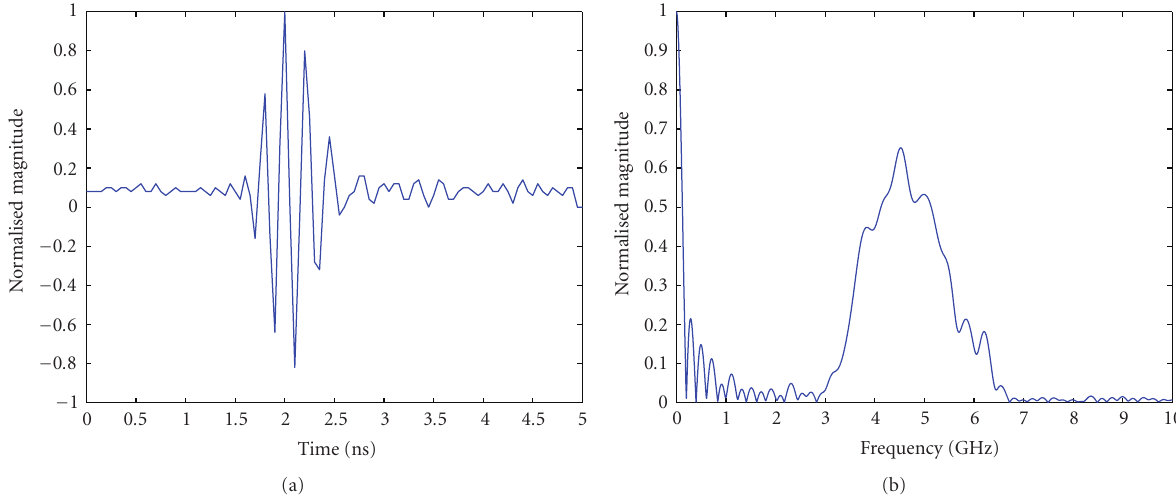
Figure 9: Temporal wave-form (a), and Wave-form spectrum obtained by FFT (b). The pulse width is around 1 nanosecond and the bandwidth is comprised of 3Ghz up to 6.2 Ghz.